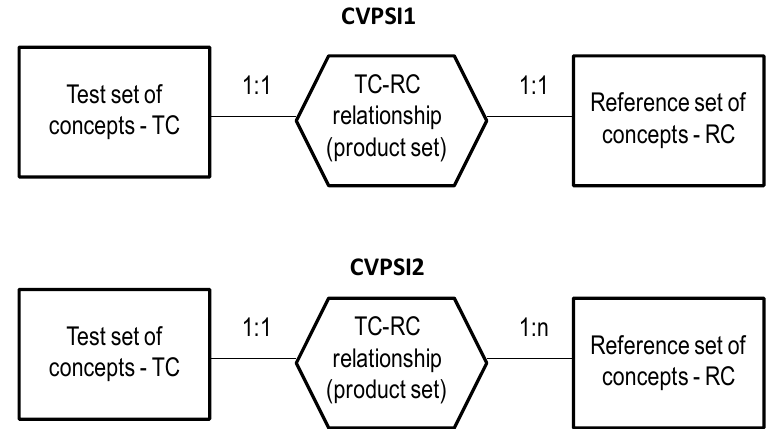
Figure A1. Entity-relationship conceptual model representation of the test class (TC)-reference class (RC) relationship and its cardinalities required in the CVPSI1 and CVPSI2